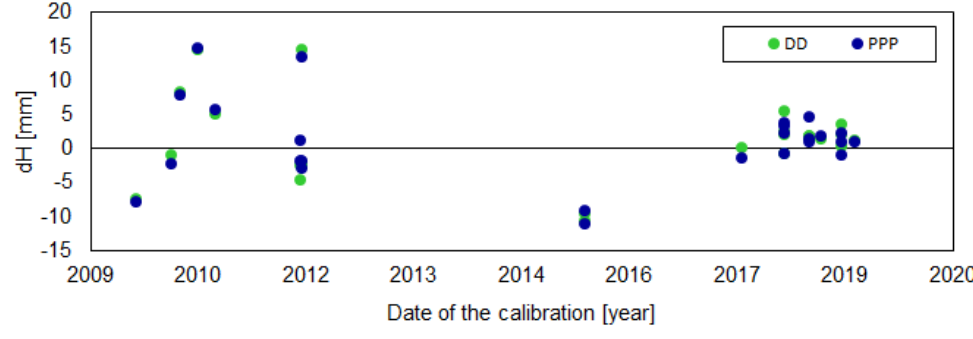
Figure 11. Dependence between height differences (G2–G1) and time of the calibrations.